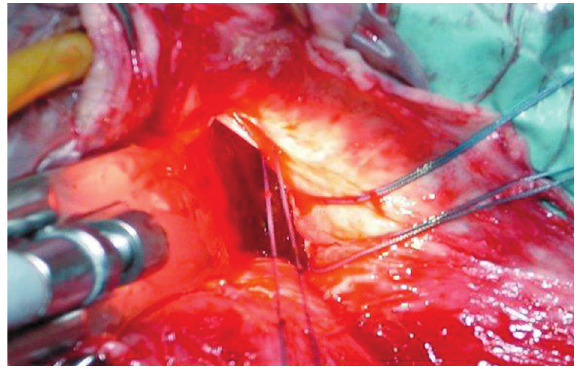
Figure 3 – Sutures placed in the white line (ATFP).